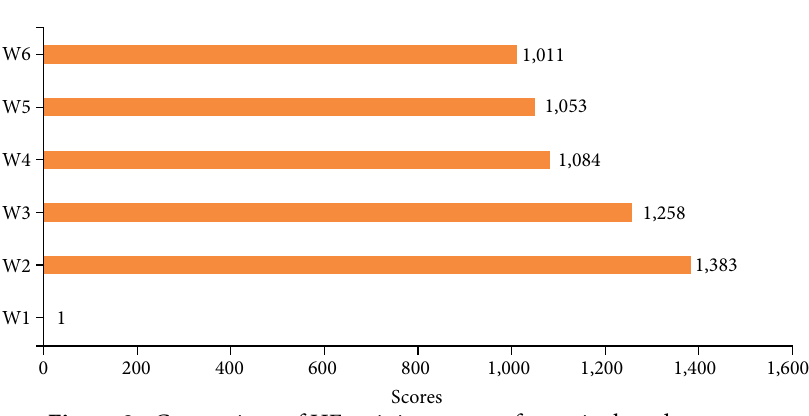
Figure 8 - Comparison of HE staining scores of rat spinal cord neurons.